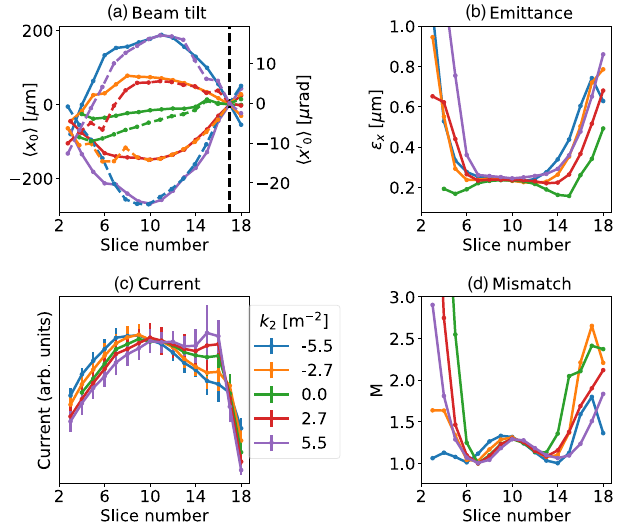
FIG. 3. Effect of a sextupole magnet on the electron beam properties. The strength ( k 2 ) of the first sextupole in BC1 was varied in five steps in the available range. The beam was streaked with the TDS after BC1. A: reconstructed slice position and angle (dashed), with slice 17 as reference. B and C: measured slice emittance and slice current. D: slice optics mismatch parameter calculated with respect to the design